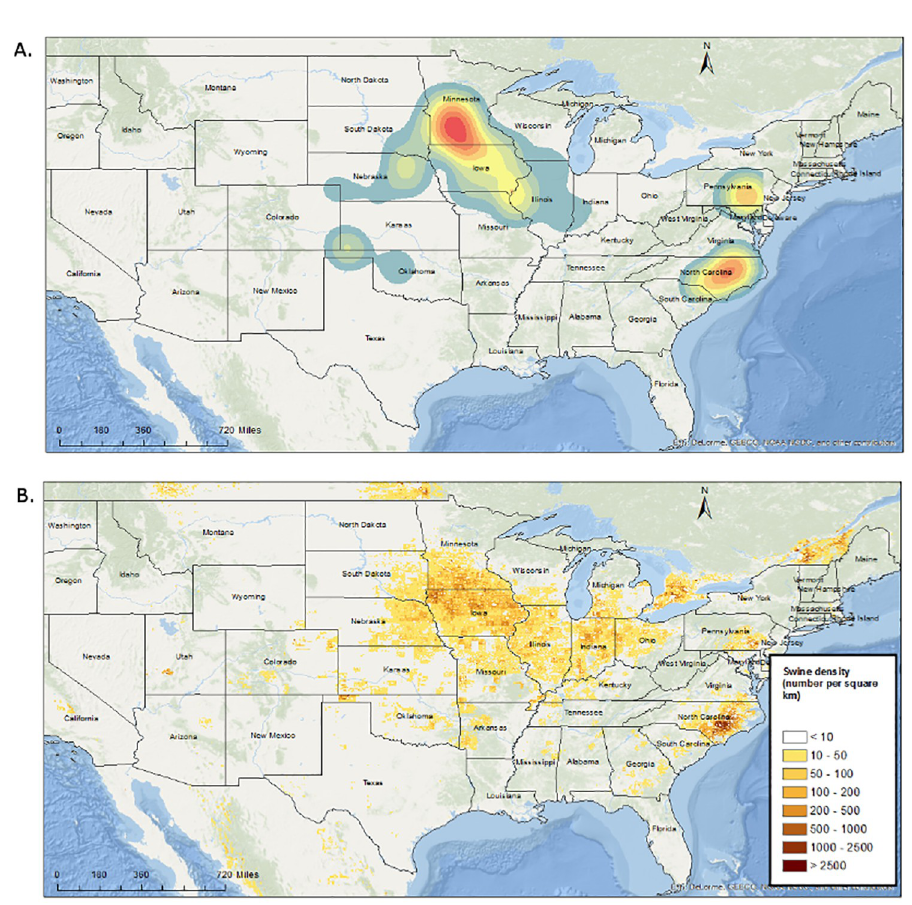
Fig 3. Kernel smoothing of sow sites participating in this study (A); and pig density from FAO projection (2005; B), createdusing ArcMap 10.2.2. Data for (B) was obtainedfrom the FAO’s GeoNetwork data repository (globallivestock densities,modelled data). This raster was predictedfor 2005, and adjusted to match FAOSTAT 2005